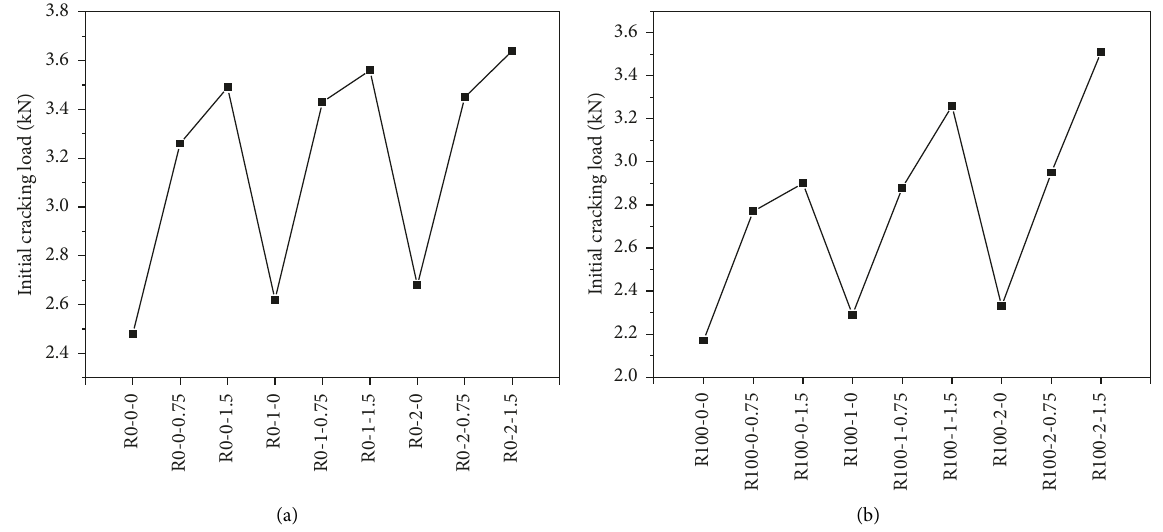
Figure 6: Initial cracking load. (a) Replacement rate of 0%. (b) Replacement rate of 100%.